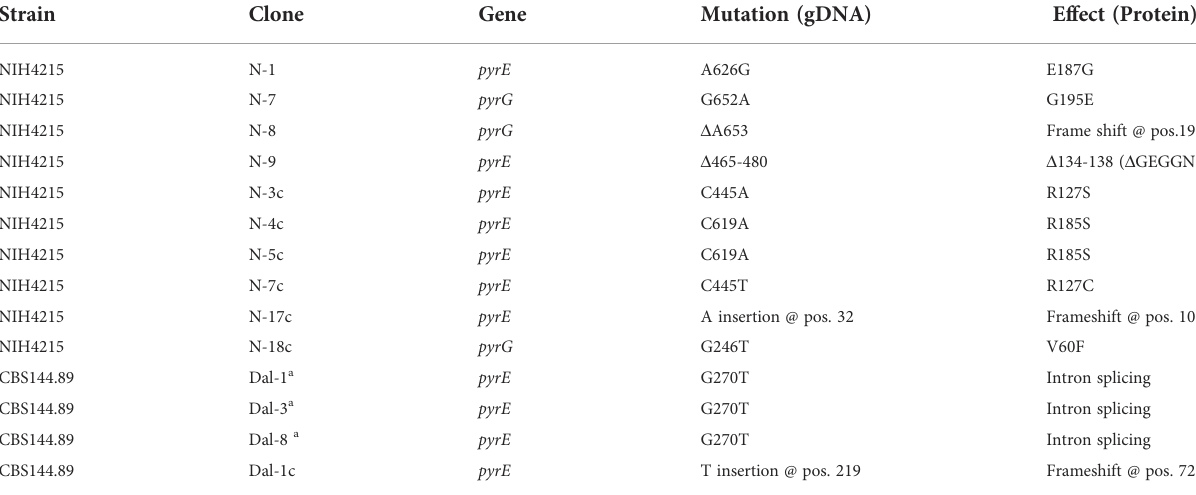
TABLE 2 Mutation analysis of fl uoroorotic acid resistant